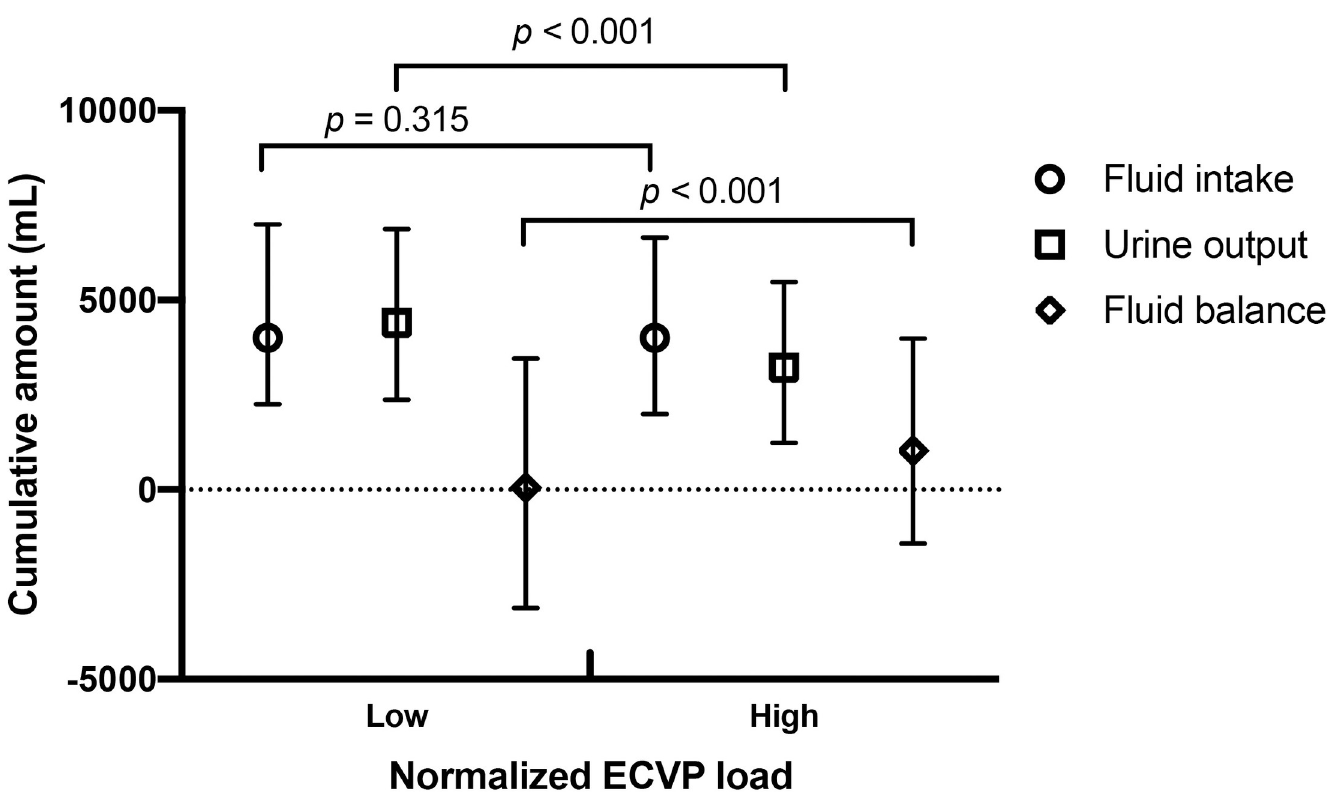
Fig 5. Fluid balance of patients with high or low normalized elevated central venous pressure load. Patients were divided into the high normalized elevated central venous pressure (ECVP) load group (n = 550) and the low normalized ECVP load group (n = 521) according to the median of normalized ECVP load. Data were presented as median and interquartile range. The high normalized ECVP load group had significantly less cumulative urine output and significantly greater fluid balance, while no significant difference in fluid input was observed.